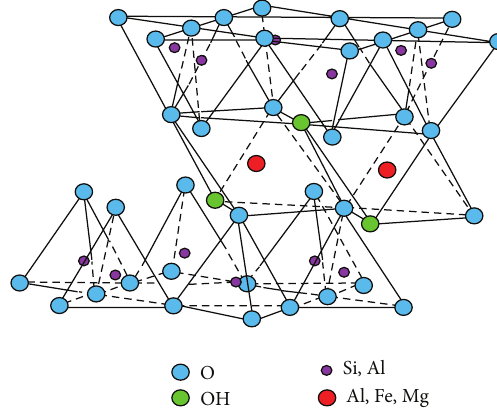
Figure 1: The structure of montmorillonite.